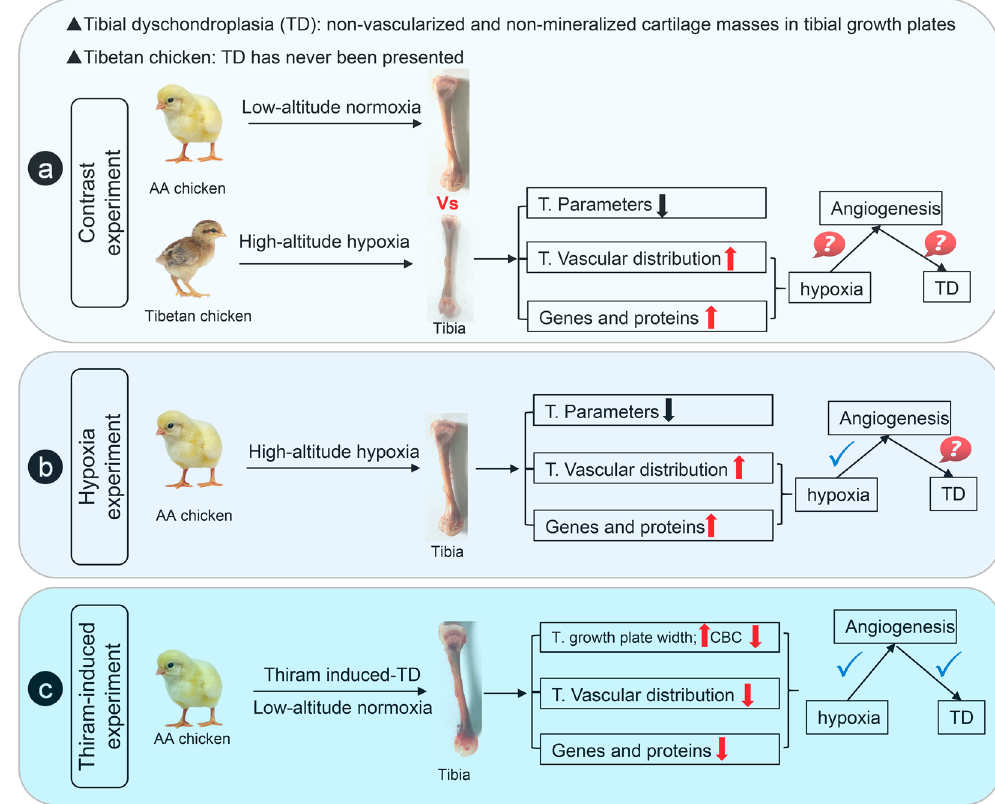
Figure 10. Flowchart for the experiments. ( a ) Contrast experiment of Tibetan chickens and AA chickens. ( b ) High-altitude hypoxia experiment in AA chickens. ( c ) Thiram-induced TD experiment in AA